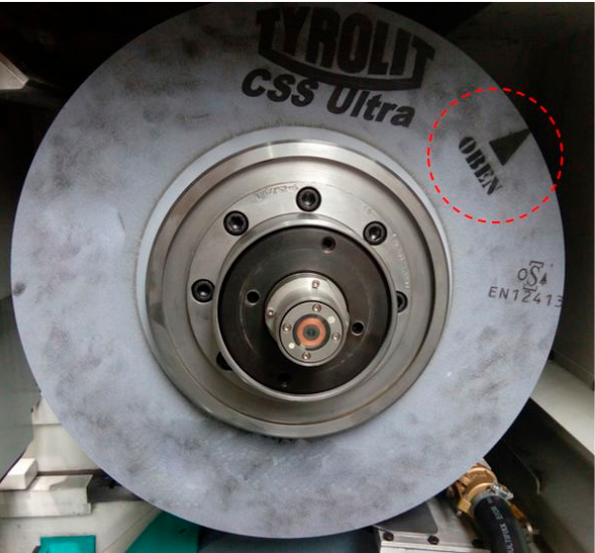
Figure 4. Illustrative picture of the grinding wheel after balancing with the “OBEN” point marked, indicating the correct orientation.